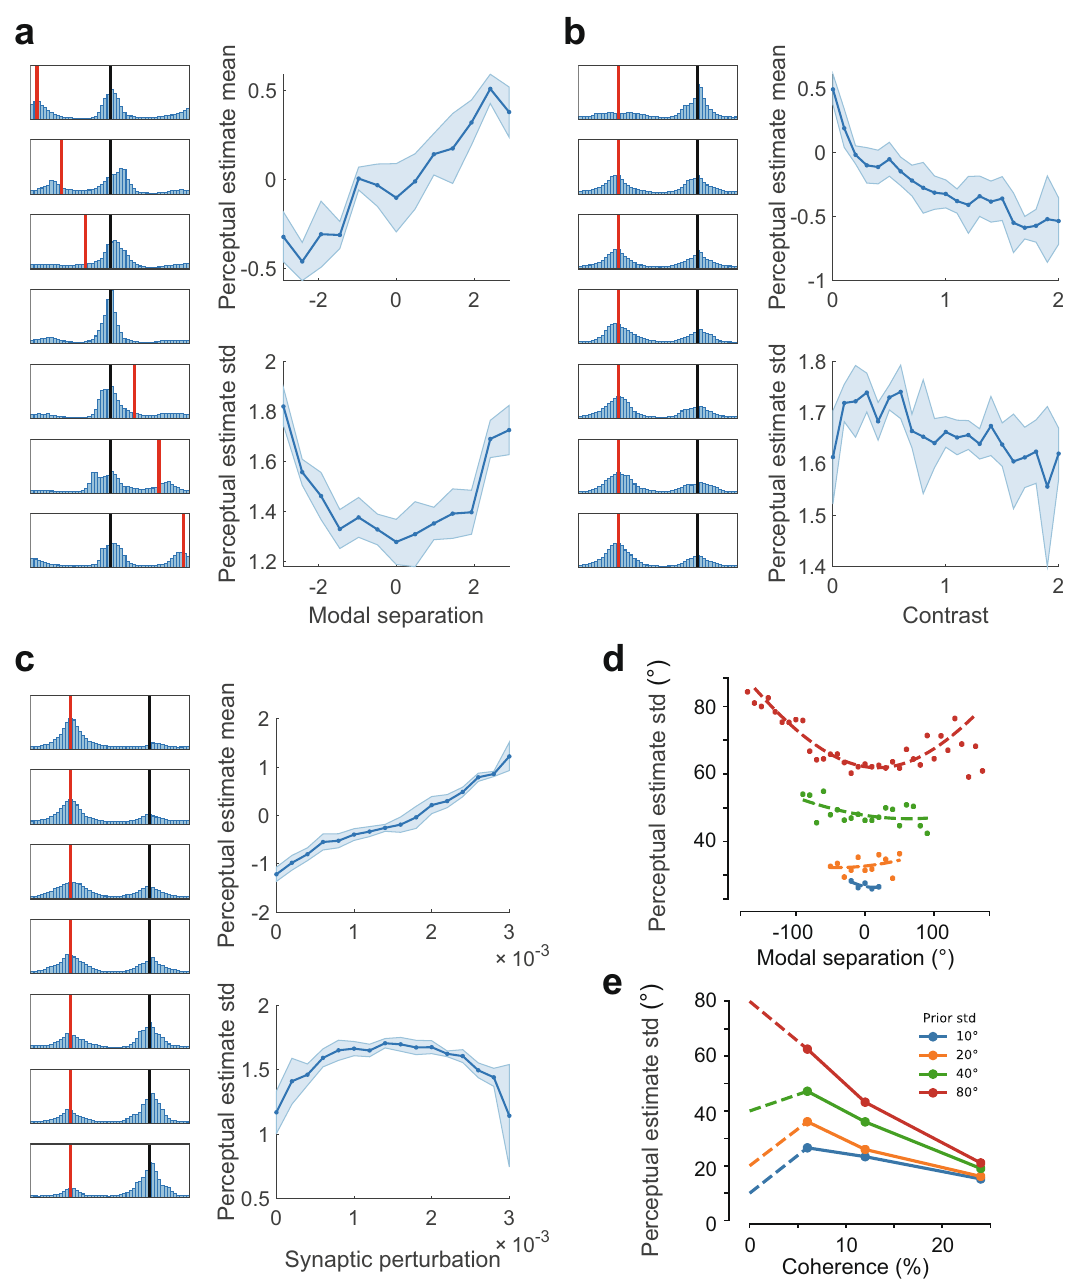
fi tted by quadratic functions (solid curves), excluding outliers due to periodic boundaryconditions.Stimuluscoherenceis fi xedat6%. e Standarddeviationofthe perceptual estimates decreases with stimulus coherence (solid lines), except for low coherence levels. Dashed lines denote extrapolations based on the theoretical argument that the perceptual estimate distribution should be equal to the prior when the coherence is zero. Modal separation is fi xed at